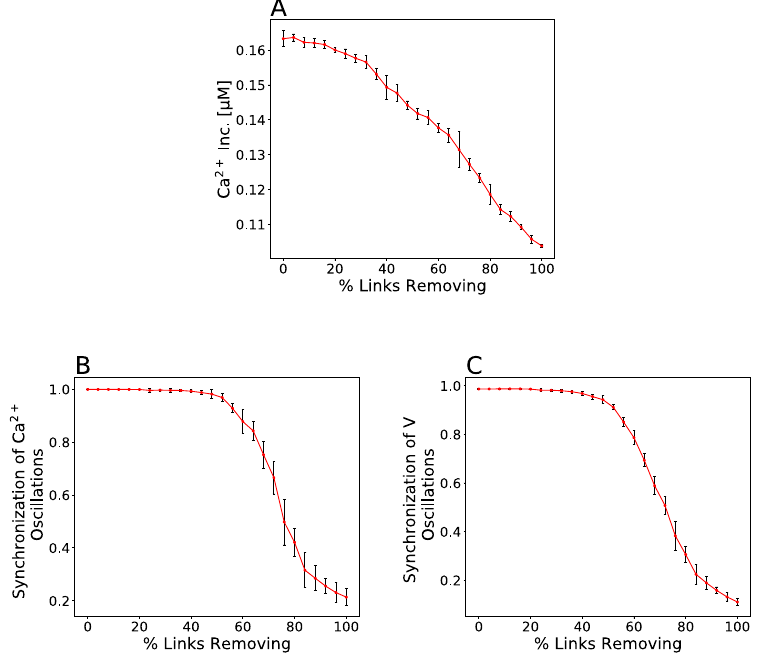
Figure 2. Gap junction coupling is more effective on Ca 2 + activity. ( A ) Mean [ Ca 2 + ] c response across the modeled islet as a function of fraction of gap junctions removed. Note that level of [ Ca 2 + ] c decreases faster after loss of ∼ 50% connections. ( B , C ) The synchrony of [ Ca 2 + ] c and membrane potential oscillations depends on fraction of gap junctions removed. Data represent the mean ± S.E.M. over 10 modeled